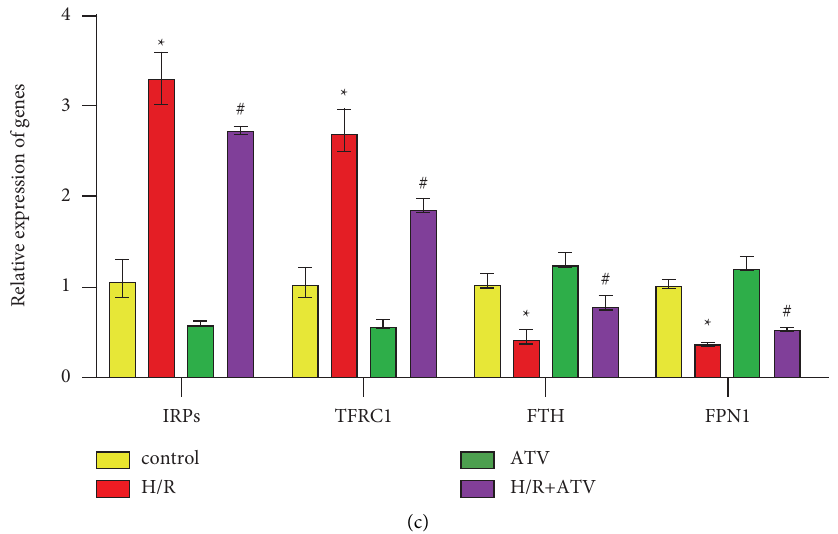
Figure 2: ATV regulated cellular iron homeostasis of H9C2 cells. (a–b). Te concentration of total iron, Fe 2+ , and hepcidin was calculated by ELISA. (c). Te relative expression of genes was measured by qPCR. ∗ P < 0 . 05 vs. the control group. # P < 0 . 05 vs. the H/R